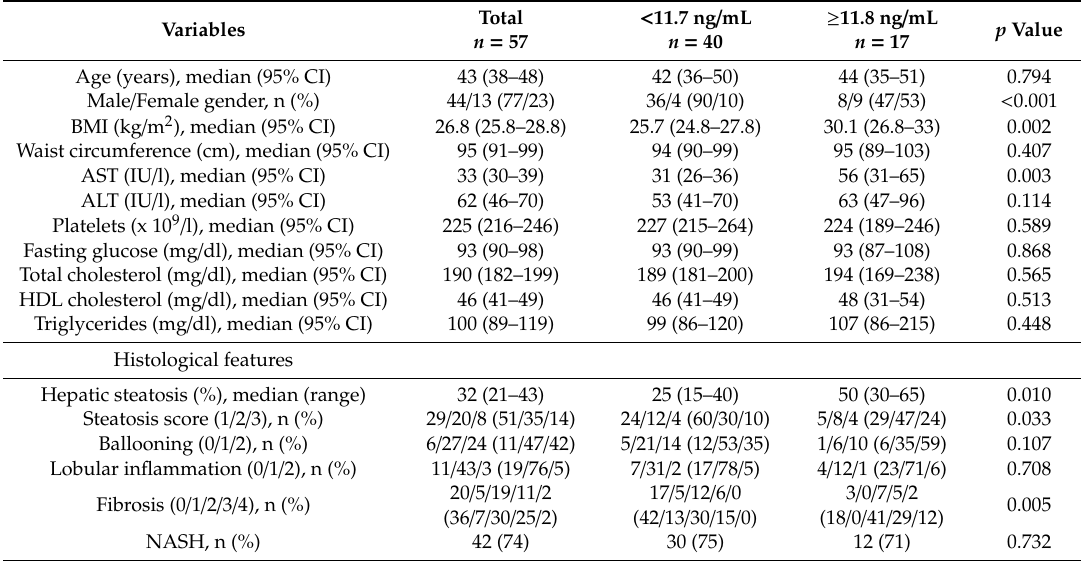
Table 1. Anthropometric, biochemical, and histological characteristics of the study cohort according to the cut-o ff value of selenoprotein P.